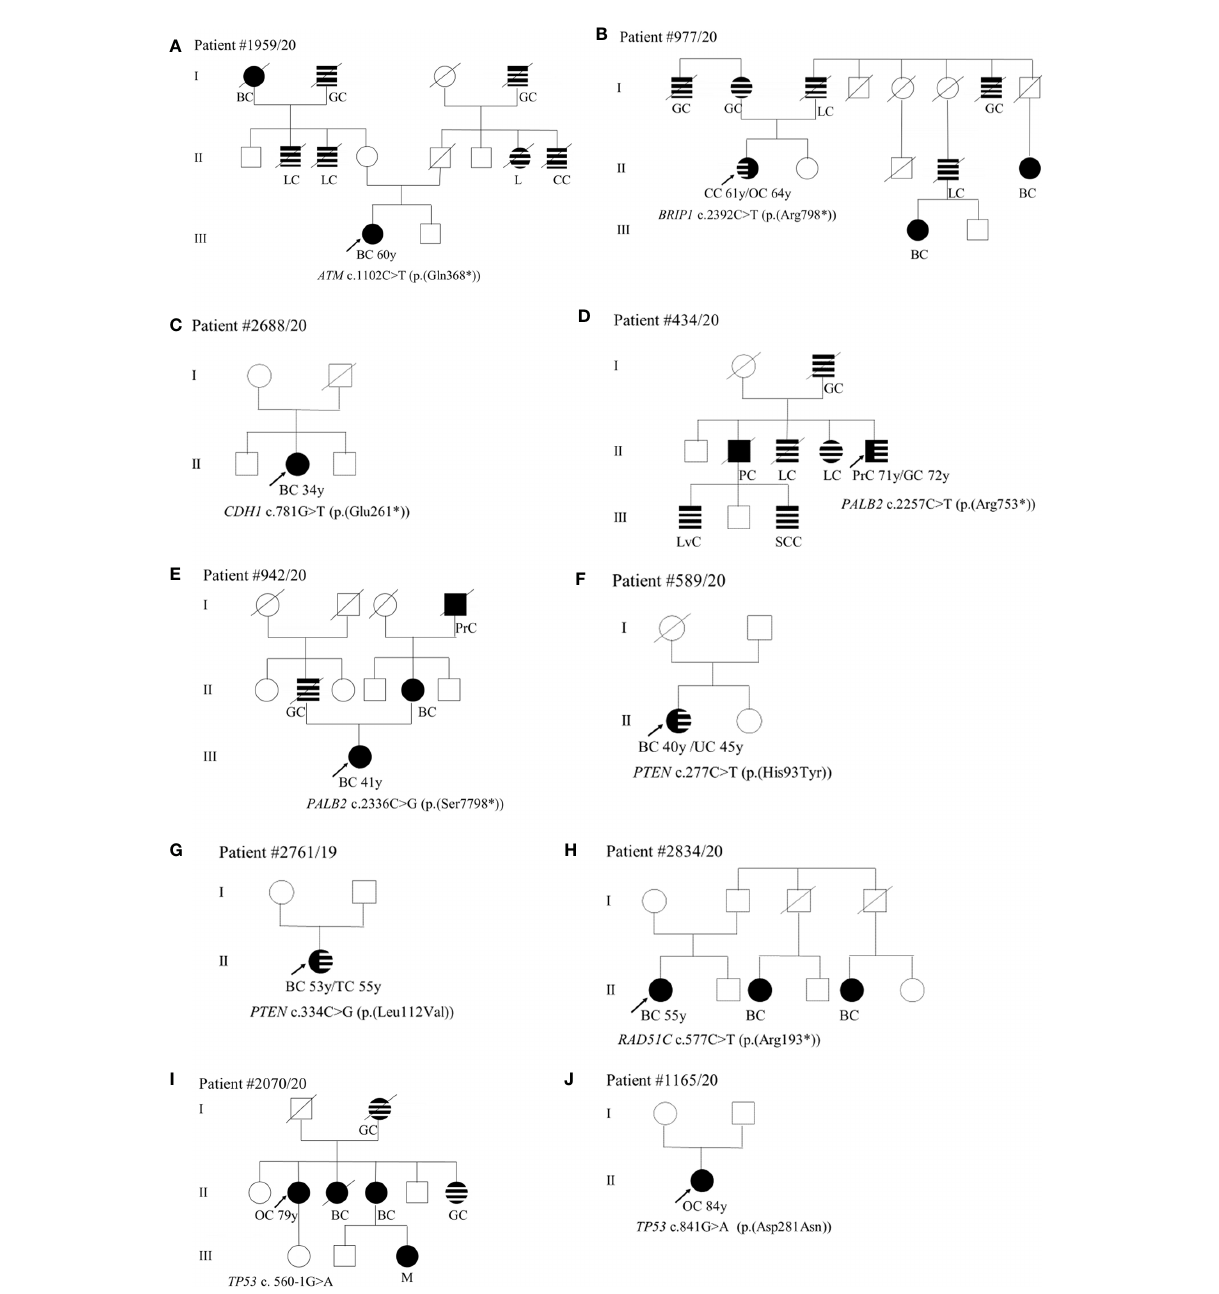
FIGURE 1 | (A – J) Pedigrees of patients carrying pathogenic variants in canonical genes. The gene and their variants are reported below the symbol of each proband. The arrows indicate the proband from each family. The black symbols indicate “ HBOC-spectrum phenotypes ” while striped symbols indicate “ other neoplasms. ” AC, abdominal cancer; BC, breast cancer; CC, colorectal cancer; GC, gastric cancer; GIC, gastrointestinal cancer; KC, kidney cancer; L, leukemia; LC, lung cancer; LvC, liver cancer; M, melanoma; OC, ovarian cancer; PC, pancreatic cancer; PrC, prostate cancer, S, sarcoma; SCC, spinal cord cancer; TC, tongue cancer; TyC, Thyroid cancer; UC, uterine cancer; X, not de fi